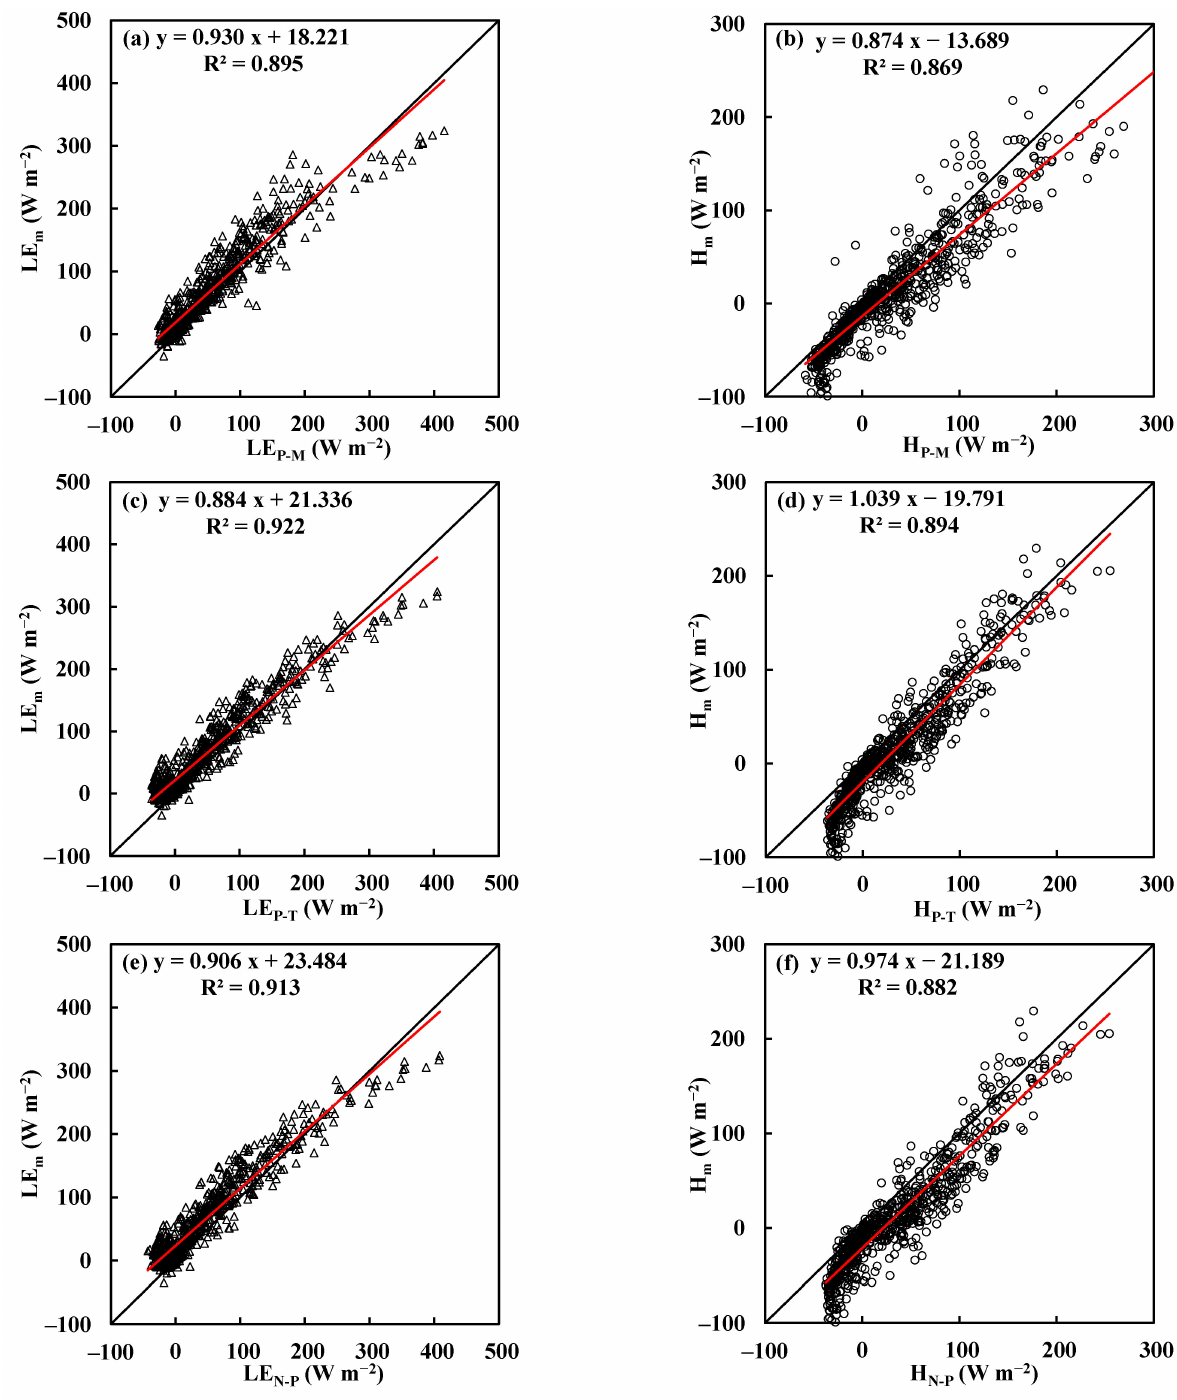
Figure 4. Comparisons of measured and predicted LE and H by the P–M equation ( a , b ), P–T equation ( c , d ), and N-P method ( e , f ) above the grassland. The 1:1 line is also